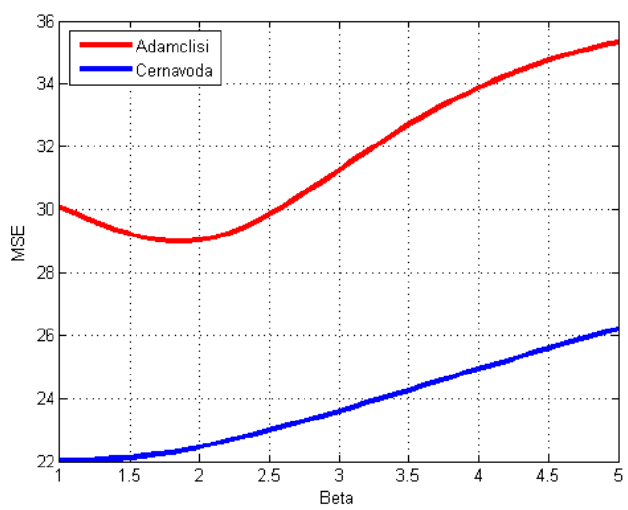
Figure 5. MSE’s for Adamclisi and Cernavoda series in a grid search with a step of 10 − 4 on the study interval.